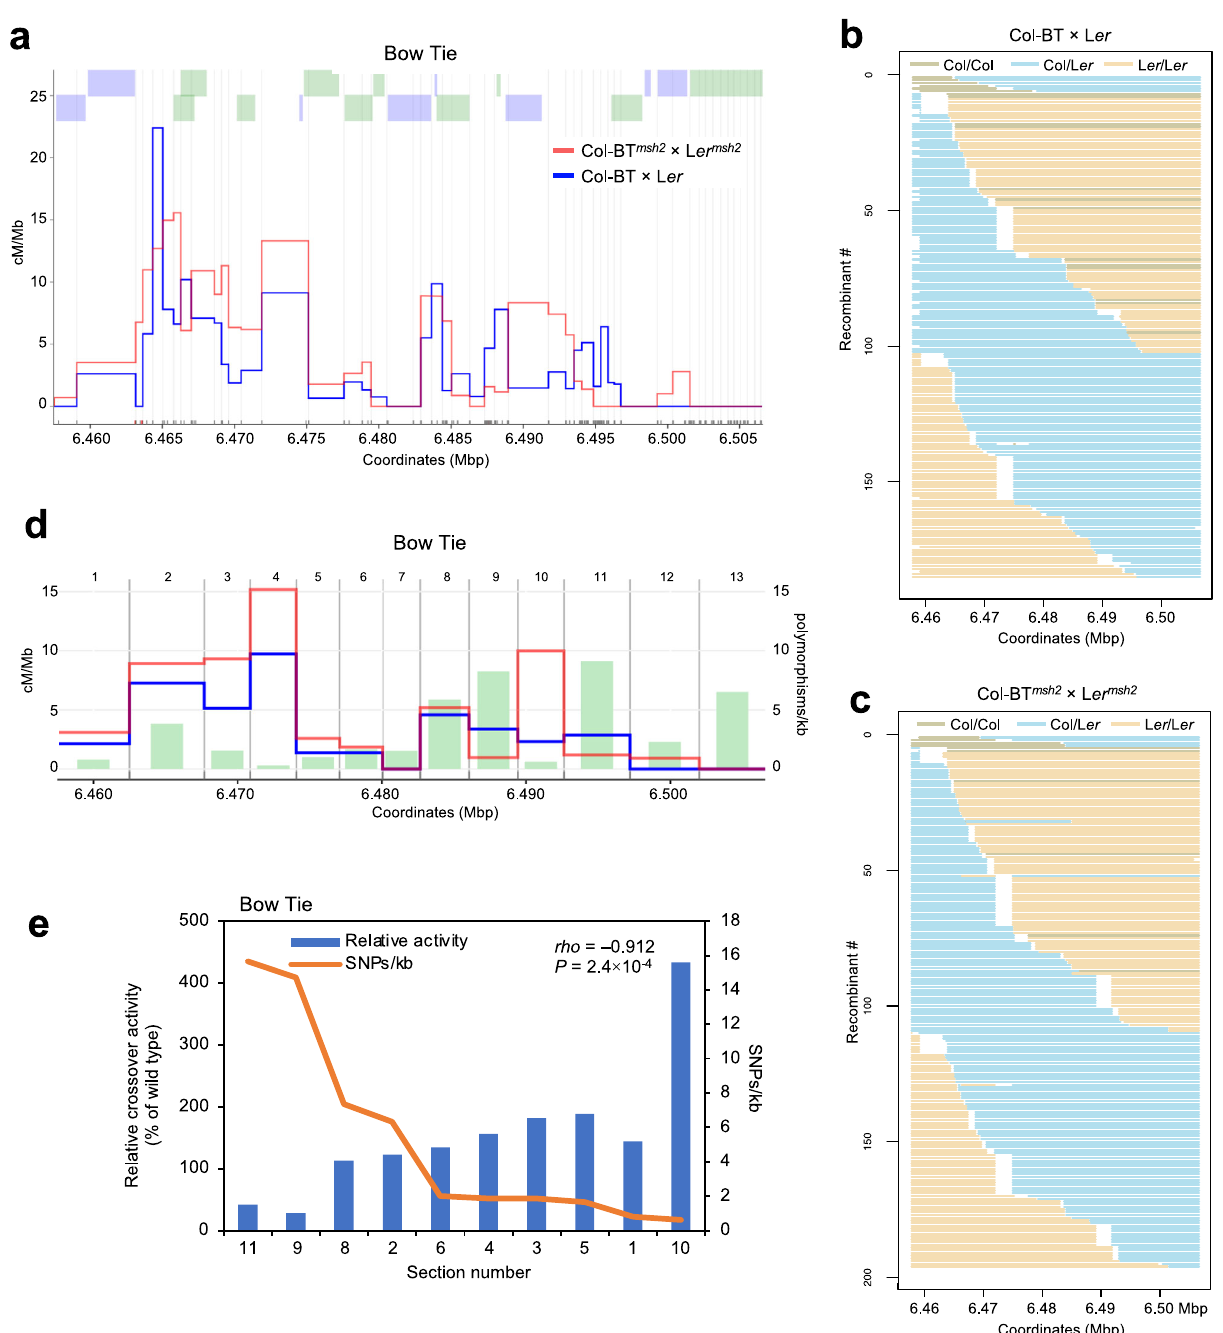
Fig. 6 | Effectsofthe msh2 mutation onCO distributionwithinthe BT interval. a CO landscapewithinthe BTintervalforthe Col-BT× L er wild type(blue)and Col- BT msh2 ×L er msh2 (red).COswerenormalizedtothemeasuredBTCOfrequency.SNPs spaced at least 400bp apart, shown as vertical gray lines, were used to determine the COtopology. The blackand red x-axis ticks correspond to all Col/L er SNPs and InDels,respectively.Genemodelsareshownbygreen(forward)orpurple(reverse) linesabovetheplot. b Genotypesof185Col-BT×L er recombinants.Eachhorizontal line corresponds to one recombinant with color-encoded genotype. The x-axes indicatecoordinateswithintheBTinterval. c Asin b ,butfor196Col-BT msh2 ×L er msh2 recombinants. d Col-BT×L er COs(blue;cM/Mb),Col-BT msh2 ×L er msh2 COs(red;cM/ Mb), and polymorphism density (green; SNPs + indels/kb) plotted in 13 sections of